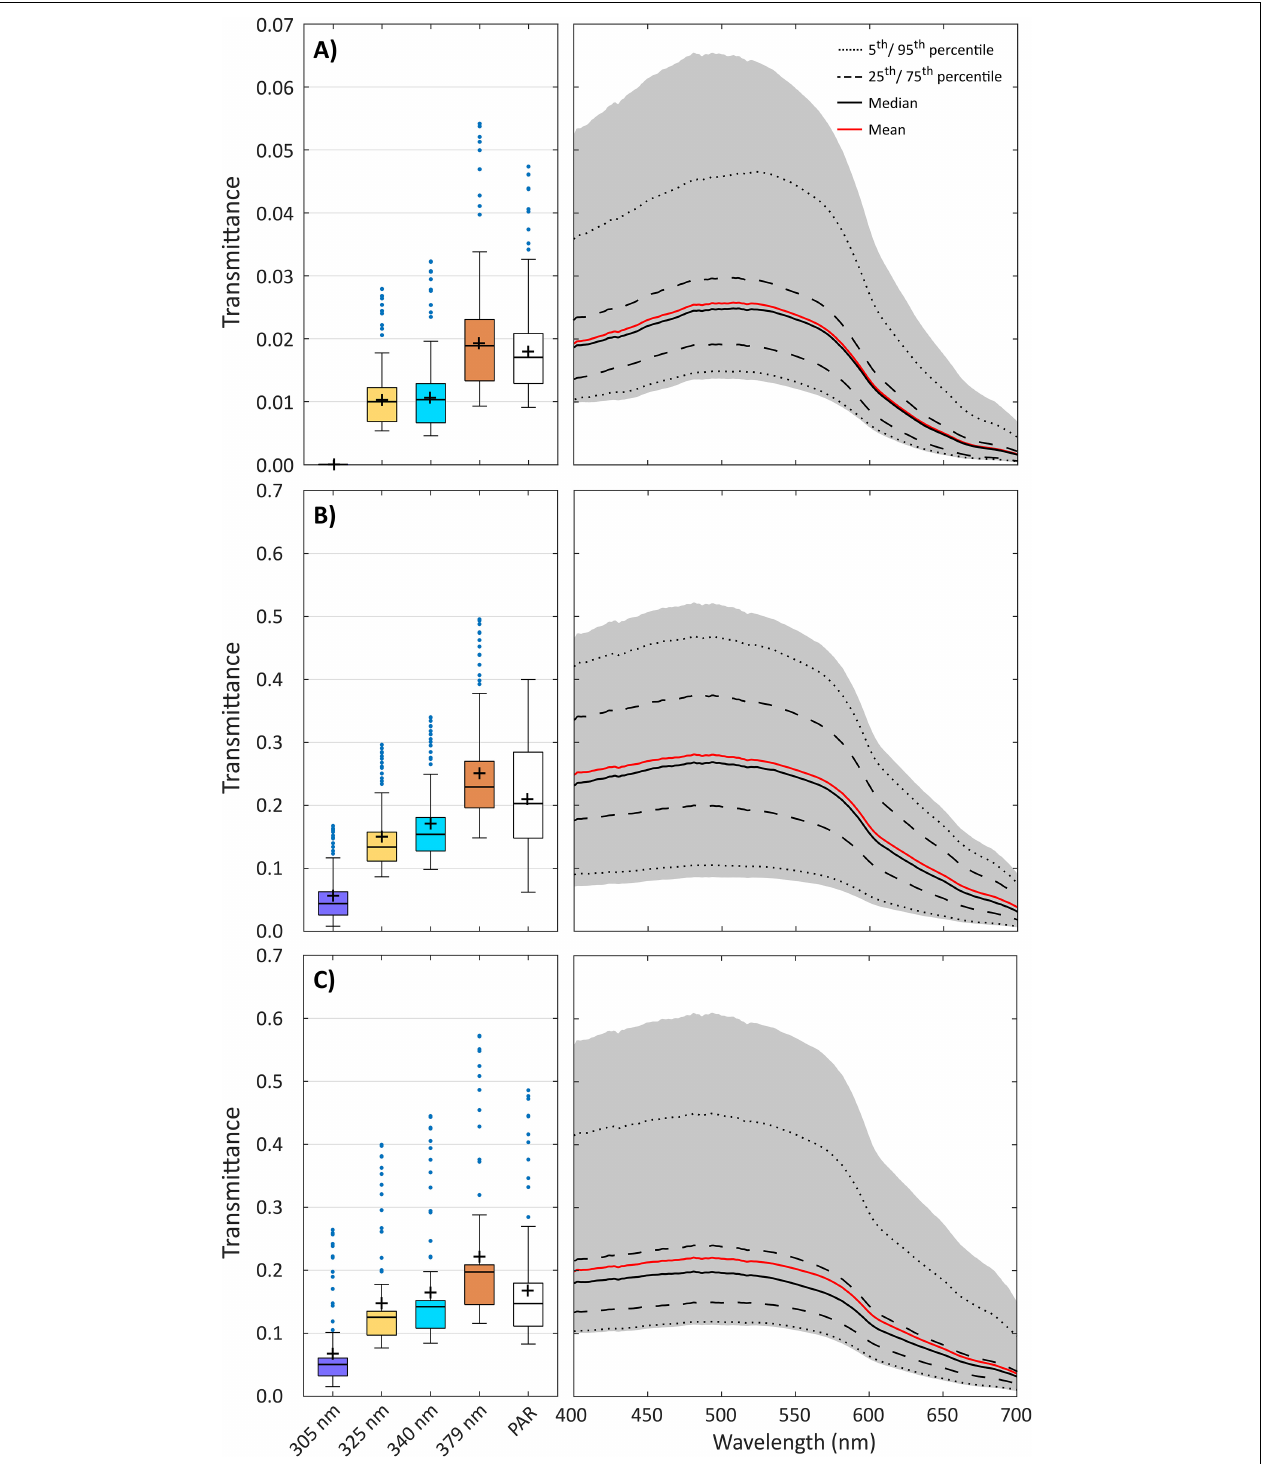
FIGURE 6 | Measured transmittance of UVR (305, 325, 340, 379 nm) and PAR along ND transect at 2-m depth on (A) 11 June, (B) 23 June, and (C) 2 July 2016. Boxplots of UVR and PAR transmittance show median (black bar), mean (cross) and the 25% and 75% quartiles of measurements along each transect. Whisker length correspond to ± 2.7 σ , outliers are shown as blue dots. Spectral irradiance in the PAR spectrum is shown for all single measurements (shaded area) along the same ND transect, and as median (black line), mean (red line), 25th/75th percentiles (dashed line) and 5th/95th percentile (dotted line).